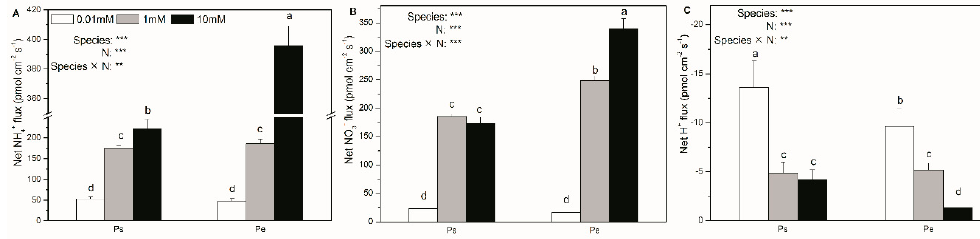
Figure 4. Net NH 4+ ( A ), NO 3 − ( B ) and H + ( C ) fluxes of P. simonii (Ps) and Populus euramericana (Pe) under 0.01, 1 and 10 mM NH 4 NO 3 . Bars labelled with different letters indicate significant difference between the treatments. p -Values of the ANOVAs of species, N treatment, and their interaction are indicated. ** p < 0.01; *** p < 0.001; ns, not significant. In both species, the root NH 4+ concentration decreased with decreasing N supply levels (Figure